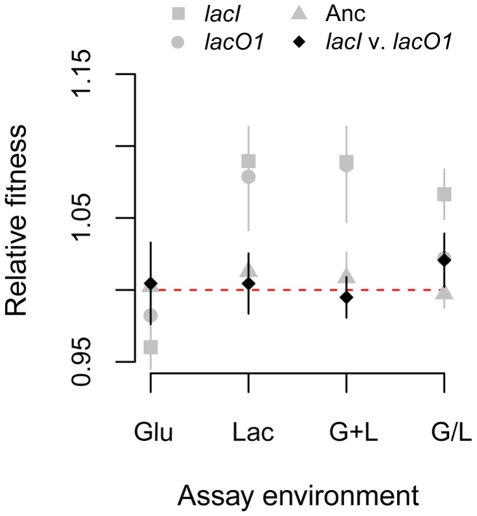
Effect of lac mutations on fitness.A) Fitness of lacI and lacO1 mutants in the four evolution environments. Competitions were performed for lacI versus the ancestor, lacO1 versus the ancestor and lacI versus lacO1. As a control, we included the ancestor competed against itself. The red dotted line indicates a relative fitness of 1 (no fitness difference). 95% confidence intervals are shown for each competition (n≥8).